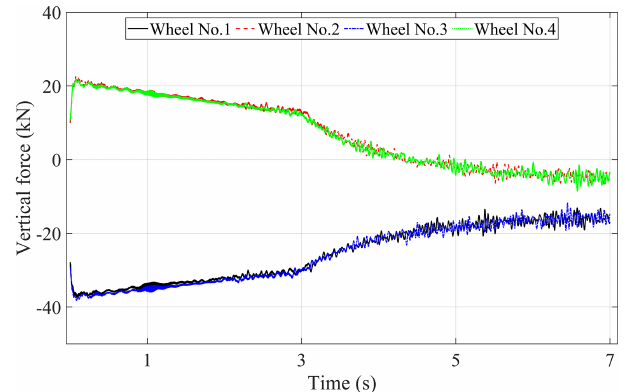
Figure 15. Forces of the suspension steeve between the gearboxes and bogie frames.